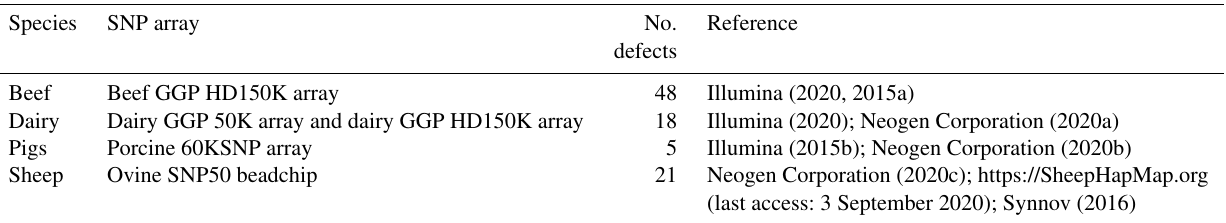
Table 3. Summary of the number of genetic defects included on SNP arrays for various livestock